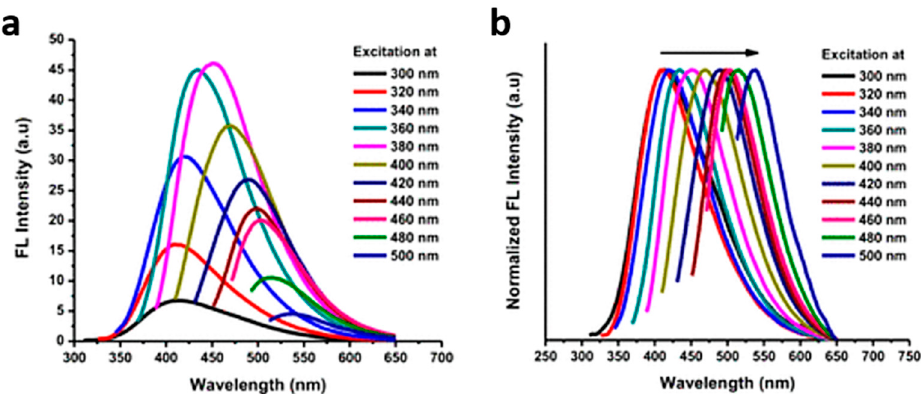
Figure 2. ( a ) Fluorescence spectrum and ( b ) normalised fluorescence spectrum of cranberry-bean-derived C-dots at excitation wavelengths between 300 and 500 nm. Reproduced with permission from reference [34], ACS Omega (https://pubs.acs.org/doi/10.1021/acsomega.9b01333); published by ACS Publishing, 2019. Requests for permission to reuse this material should be directed to the ACS.